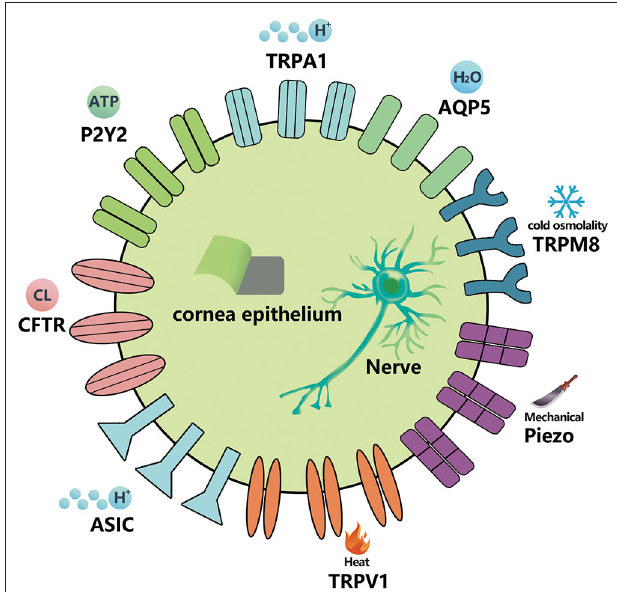
FIGURE 1 | Ion-channels that exist in the cornea, conjunctival epithelial cells, and corneal nerve fibers. The specific stimuli activating each receptor channel class is shown (11,